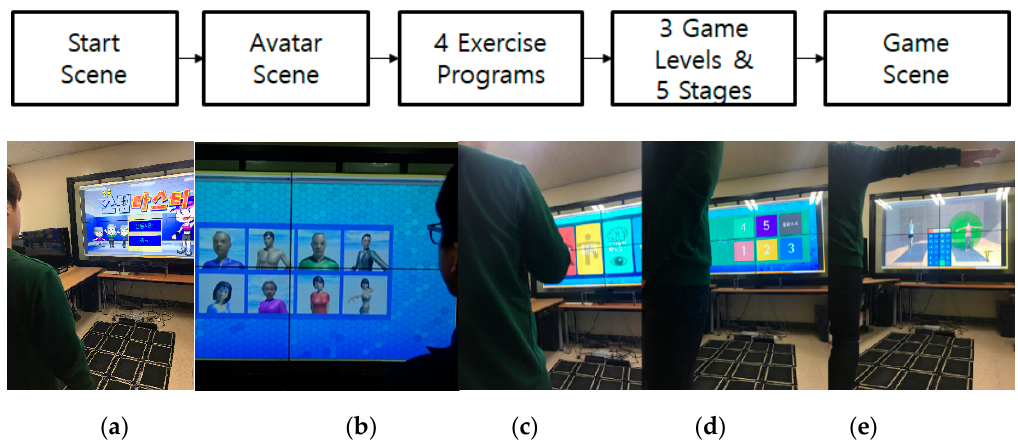
Figure 7. Screenshots of the Chongchong Step Master exergame ( a ) start, ( b ) avatar selection, ( c ) exercise program selection, ( d ) game level selection, and ( e ) game play scene.